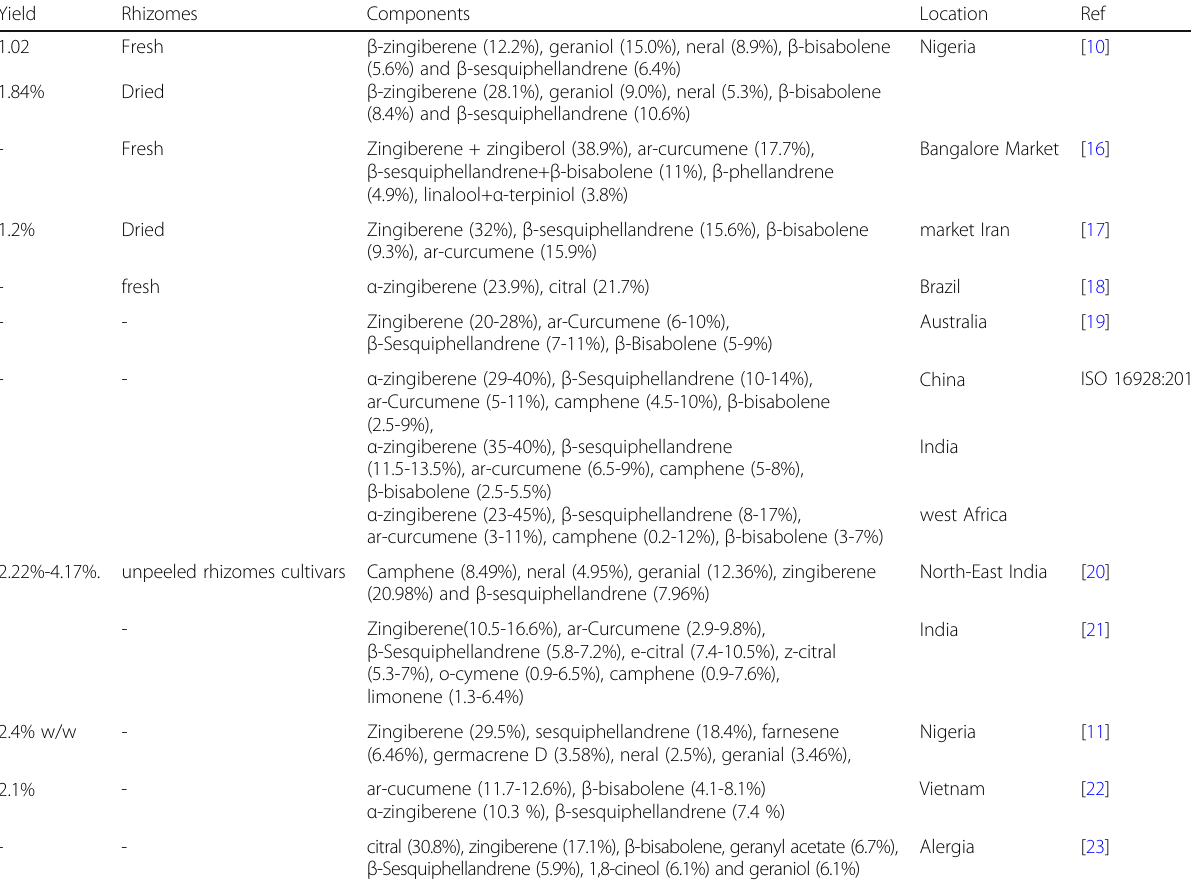
Table 1 The chemical composition of Zingiber officinale essential oil from different geographical region